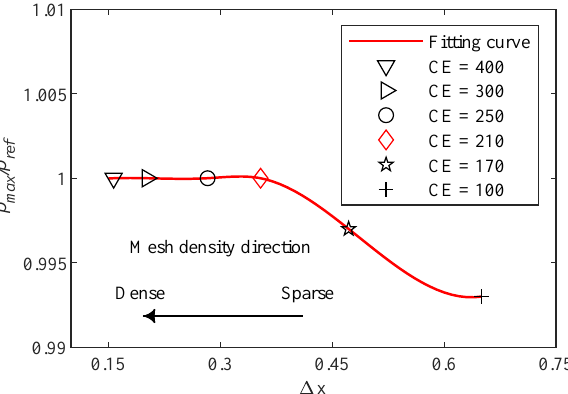
Figure 3. Mesh convergence in the x